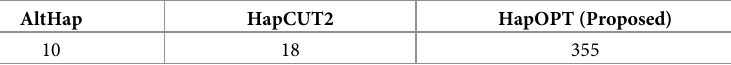
Table 6. Runtime of HapOPT, HapCUT2, AltHap, and SDhaP on real fosmid data. SDhaP AltHap HapCUT2 HapOPT (Proposed) Runtime (Minutes) 5 10 18